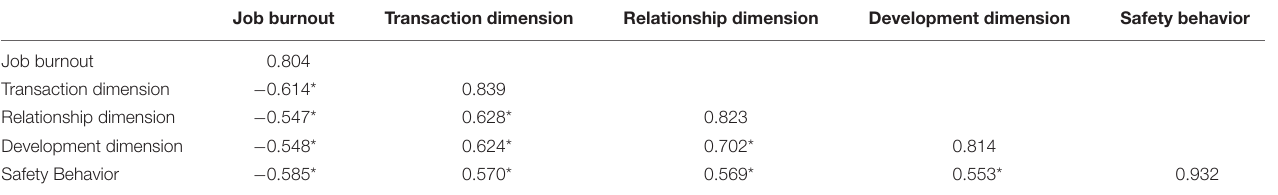
TABLE 6 | Correlation coefficient and AVE square root between variables ( N = 353).